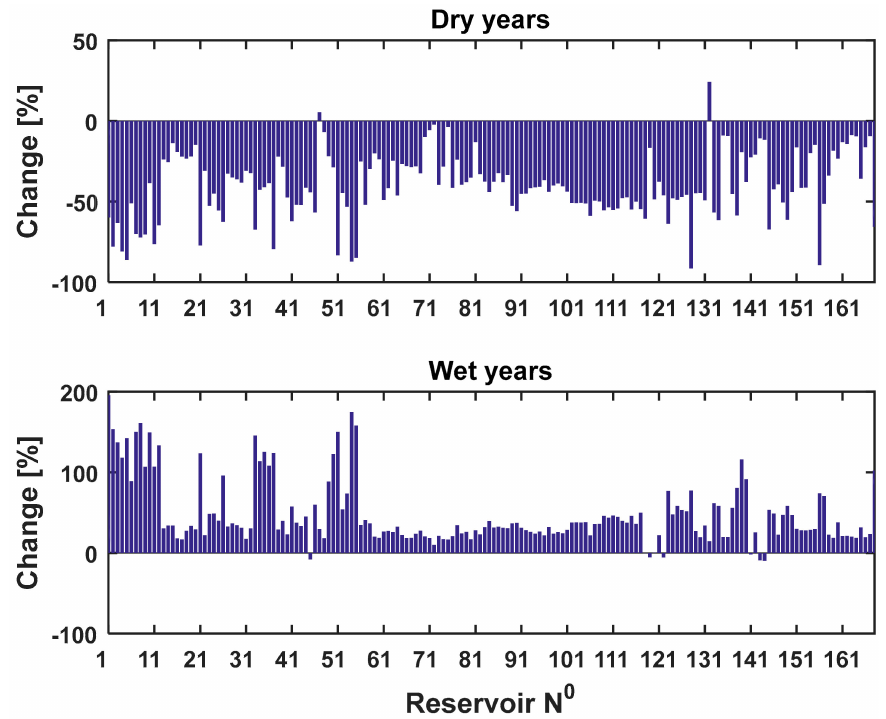
Figure 13. Composite anomalies of the inflow discharge for dry and wet